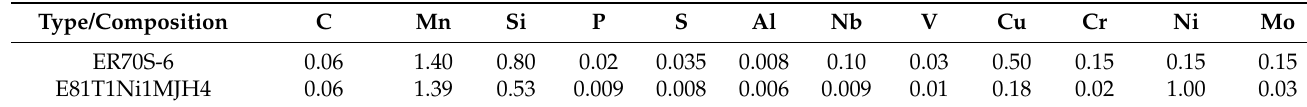
Table 4. Chemical composition of welding wire.